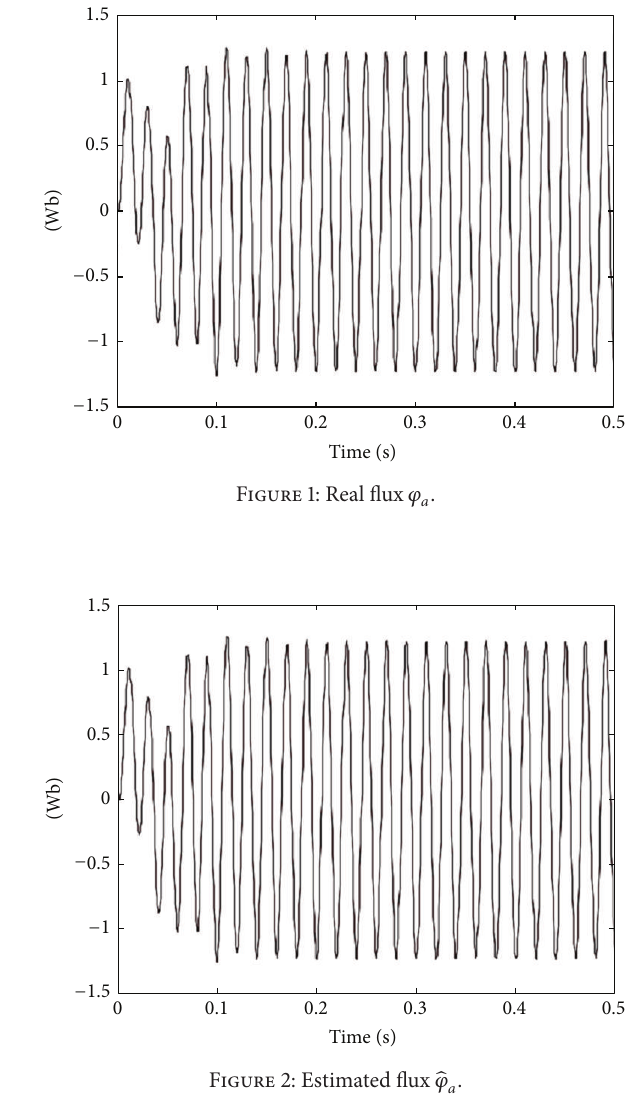
Figure 2: Estimated flux ̂𝜑 𝑎